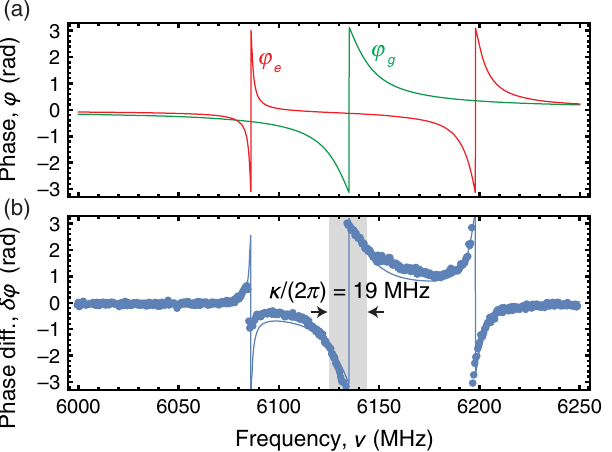
FIG. 2. (a) Expected phase φ ( φ ) of a weak coherent signal g e upon reflection off of the cavity-atom system, when the detection qubit is in j g i (green) [ j e i (red)]. (b) Phase difference δφ measured in pulsed spectroscopy (blue dots) compared to the − φ calculated value of φ (solid line; see Appendix D). The g e linewidth κ = ð 2 π Þ of the bare cavity is indicated by the shaded area.